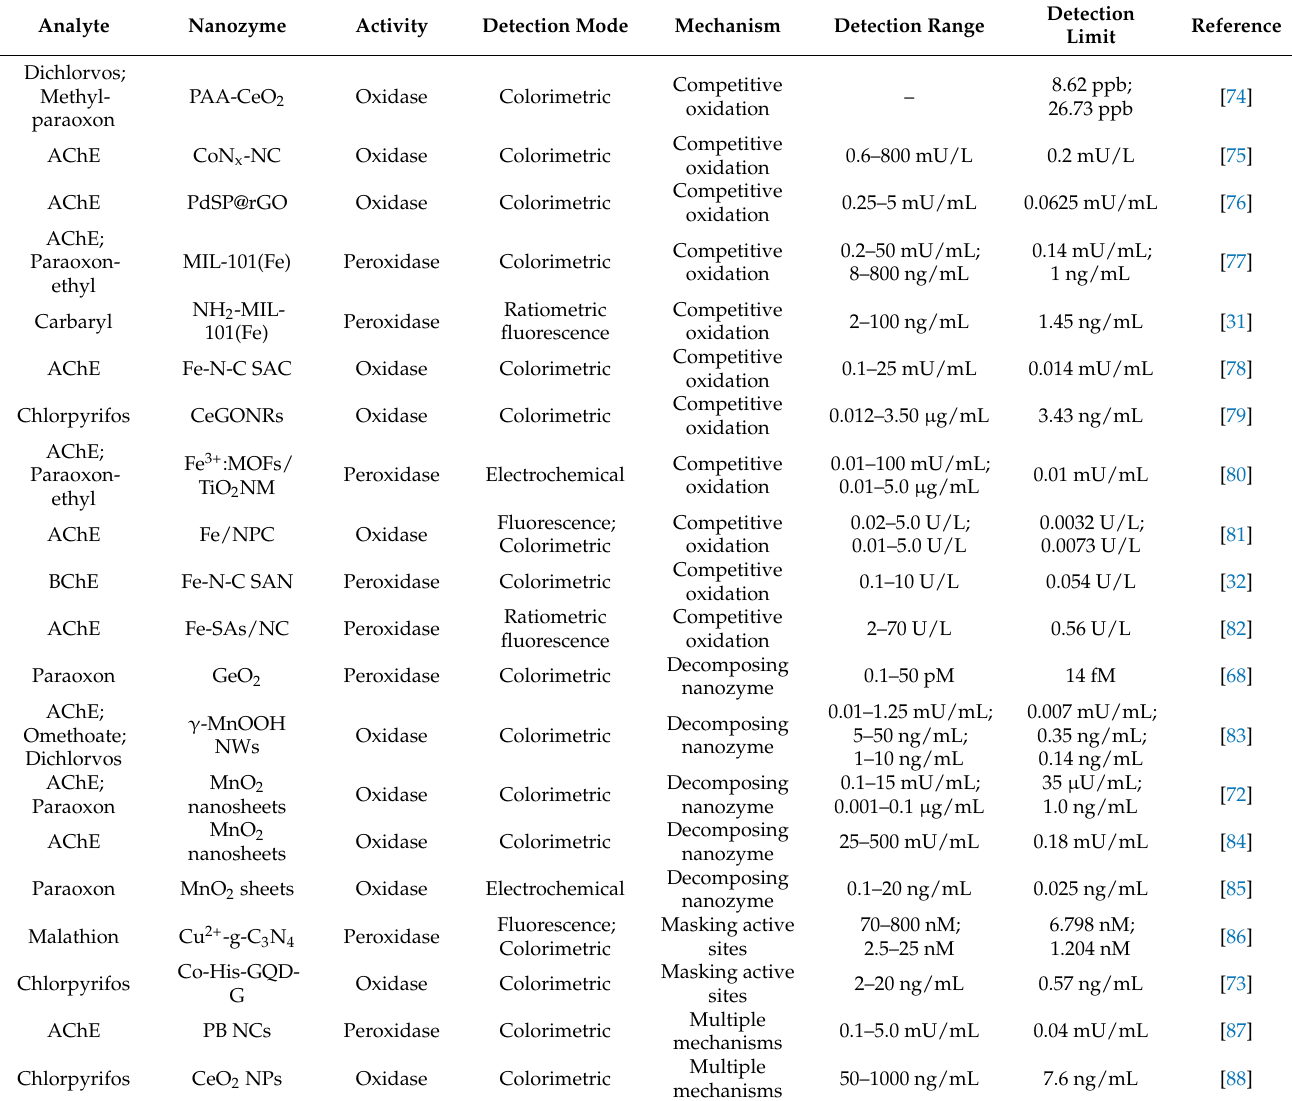
Table 1. Nanozyme-involved detection of pesticides and cholinesterases based on different mechanisms caused by the generation of thiol-containing